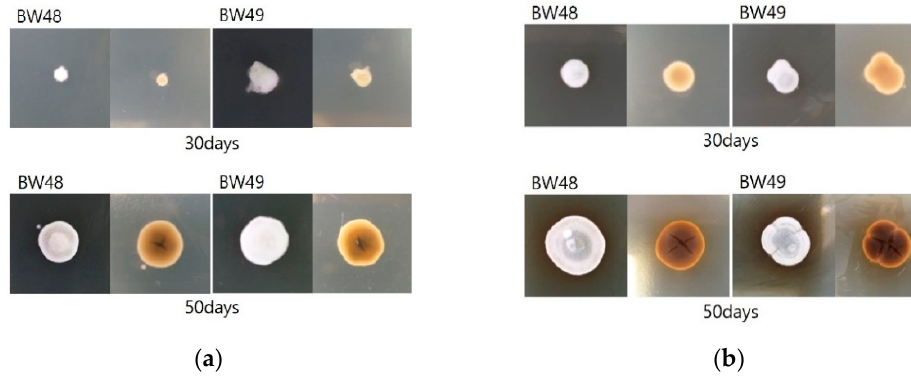
Figure 5. Morphology of isolated Pd according to the time period for growth. Cultured fungal colonies changed from a white and cottony appearance to gray, and fungal colonies cultured on SDA medium secreted a brown pigment: ( a ) DPYA Media; ( b ) SDA Media.